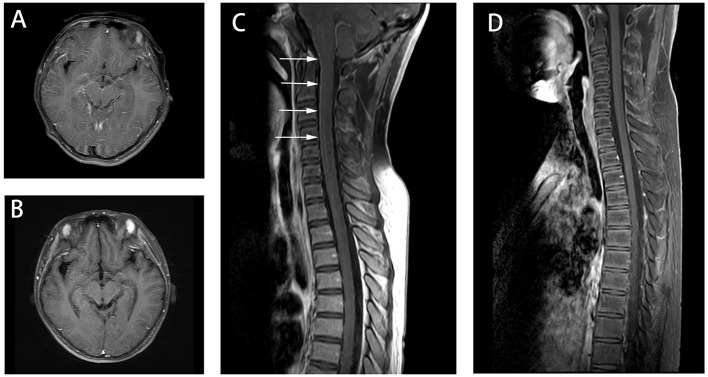
Axial fluid attenuation inversion recovery (FLAIR) MRI brain (A) 7 days after admission and (B) 3 weeks later. Image (A) showed the enhancement in the surface of the large and small brain as well as brainstem (not shown). Image (B) showed meningeal enhancement was reduced. Spine MRI (C) 10 days after admission and (D) 3 weeks later. Image (C) showed the enhancement of spine. And Image (D) showed the enhancement was reduced after the immunotherapy treatment.